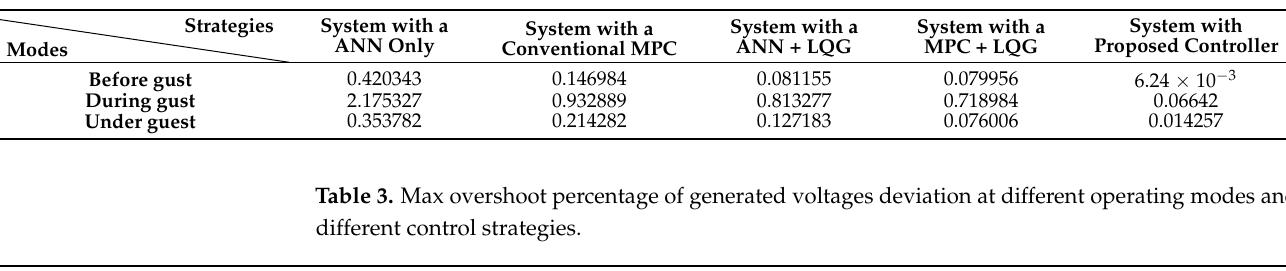
Figure 13. Max overshoot in generated voltages at different operating modes.